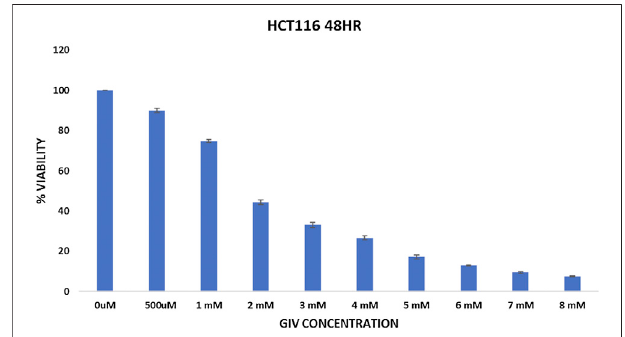
FIGURE 1 | Cytotoxicity of GIV evaluated using MTT assay. GIV shows IC 50 around 1.6 – 1.8 mM concentration. The x-axis denotes GIV concentration and y-axis represents percentage viability. Data are represented as mean ± SD values of three independent experiments for 48 h of incubation, and p value < 0.05 is considered signi fi